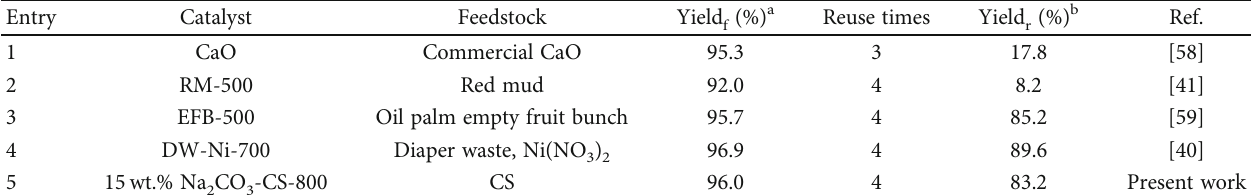
CO -CS-800 with recently reported heterogeneous catalysts. 2 3